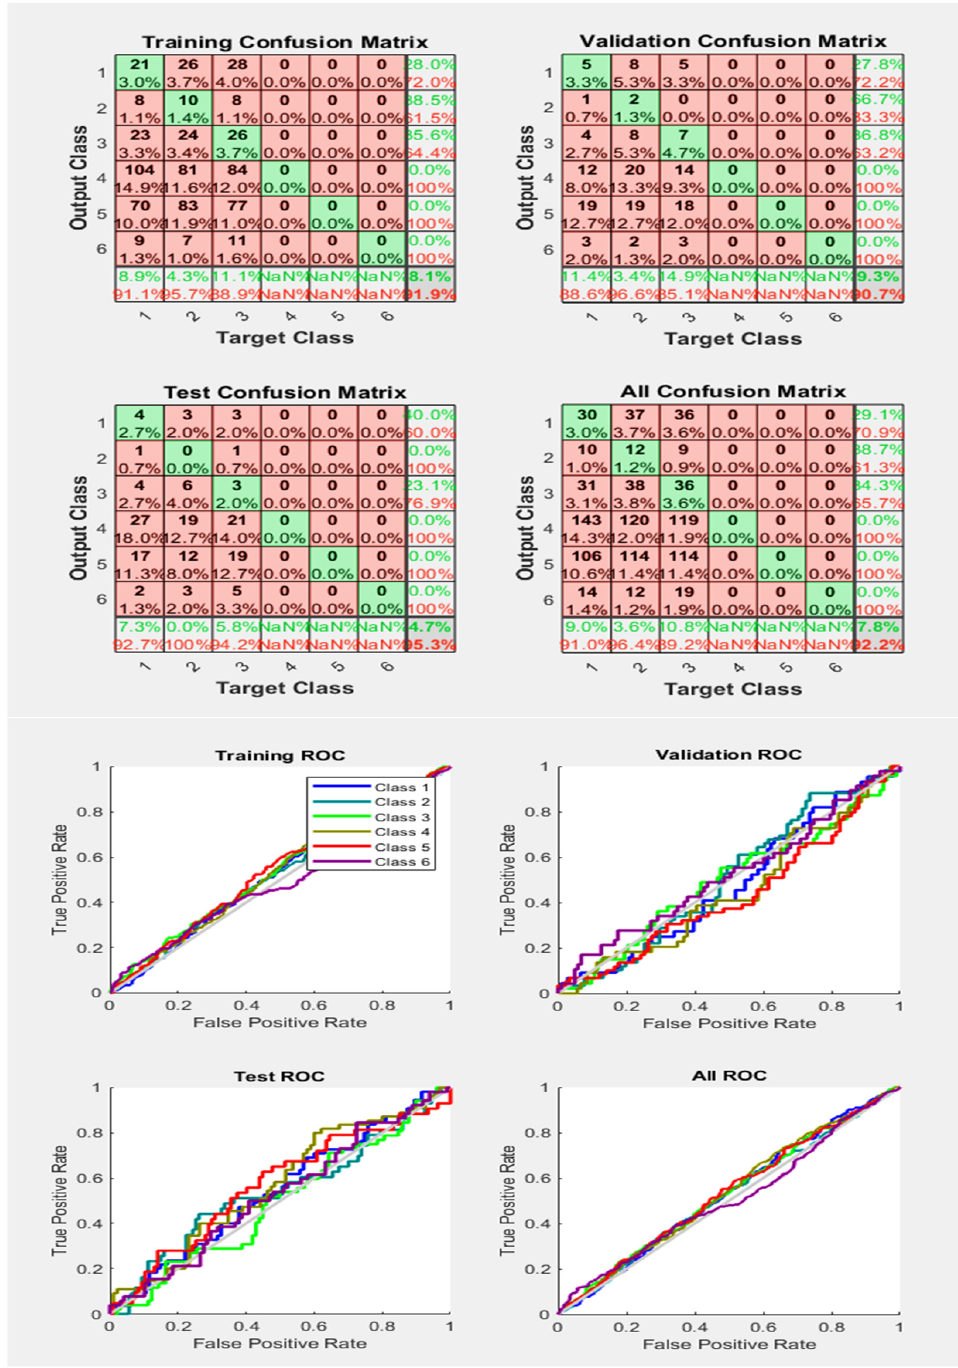
Figure 16. Neural Network Model ROC (Receiver Operating Characteristics) and Confusion Matrix for OSS TrainFcn/Activation Function at level 9 (RMS) Features for High Contact Resistance Fault with 92.2% Accuracy. Grey line shows diagonal of the ROC for indicating Class 1–6 lines are lying above or below or on it.